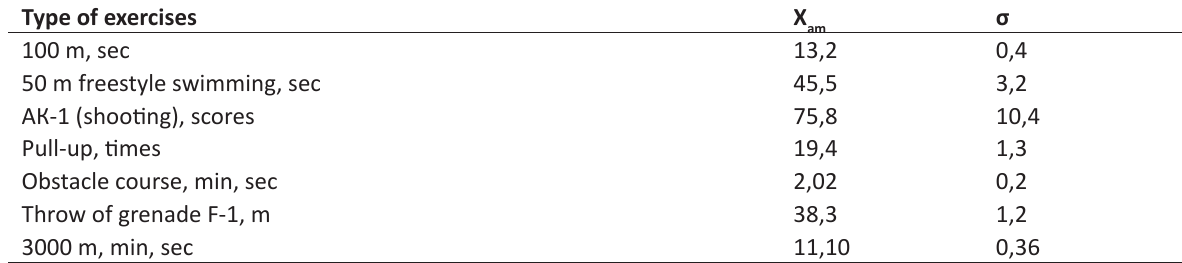
Table 2. Results of cadets’ preliminary monitoring fulfillment of seven types of sport applied multiathlon, (n=20) Type of